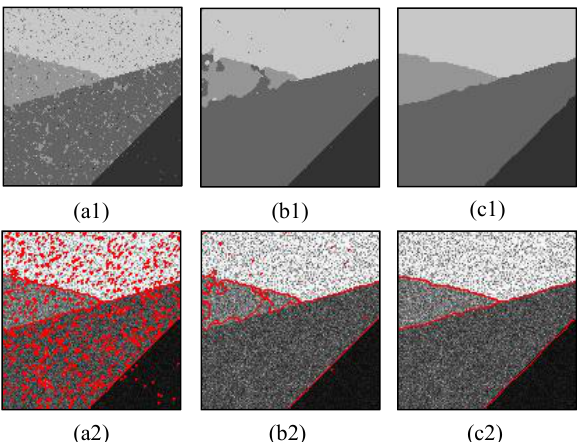
Figure 3. Segmentation results and outline added